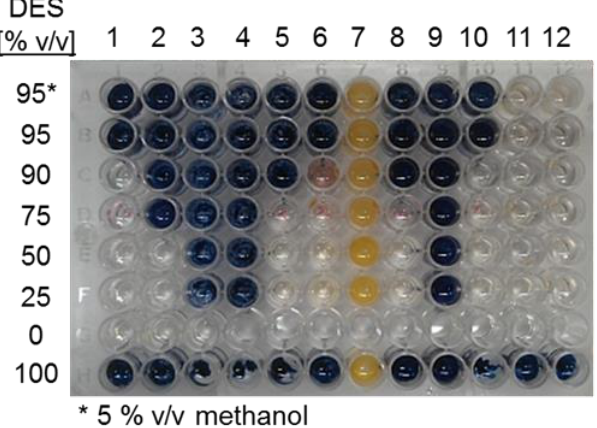
Figure 2. Screening for α -amylase stability in DES:water cosolvent mixtures as detected by the I - / I 2 staining assay with amylose, after 4h reactions in the corresponding DES. 1 . choline chloride:urea